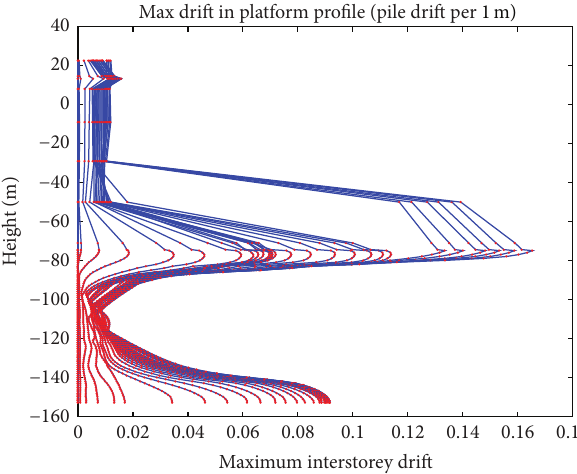
Figure 9: The profile of the maximum drift ratio in different elevations of the platform from the pile tip up to the deck